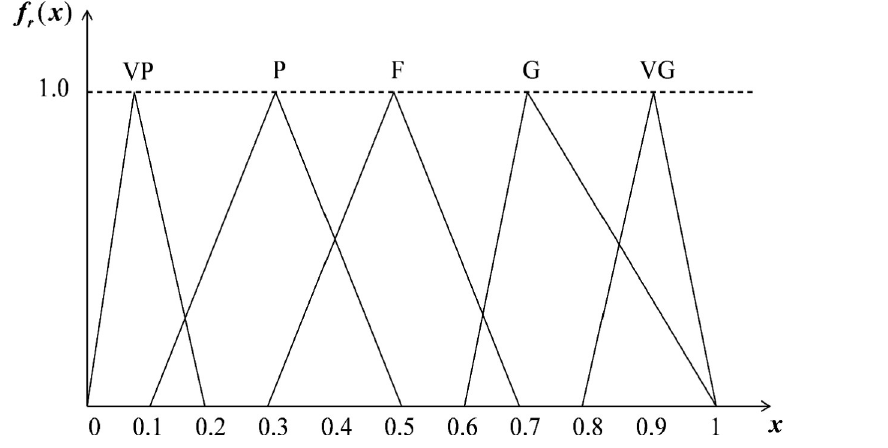
Fig 1. Membership functions of linguistic variables for measuring rating of alternatives.